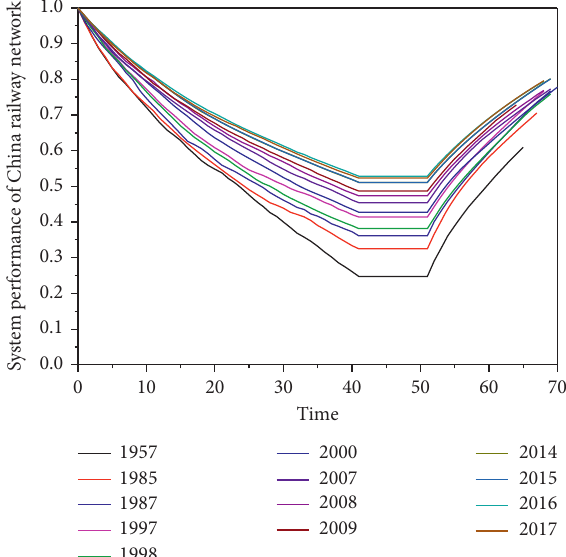
Figure 6: Formation path of China railway network system